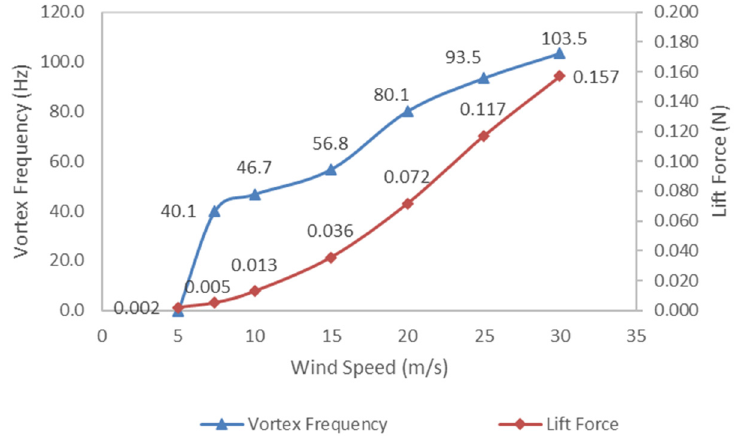
Figure 11. Vortex frequency and lift force created under different wind speeds.